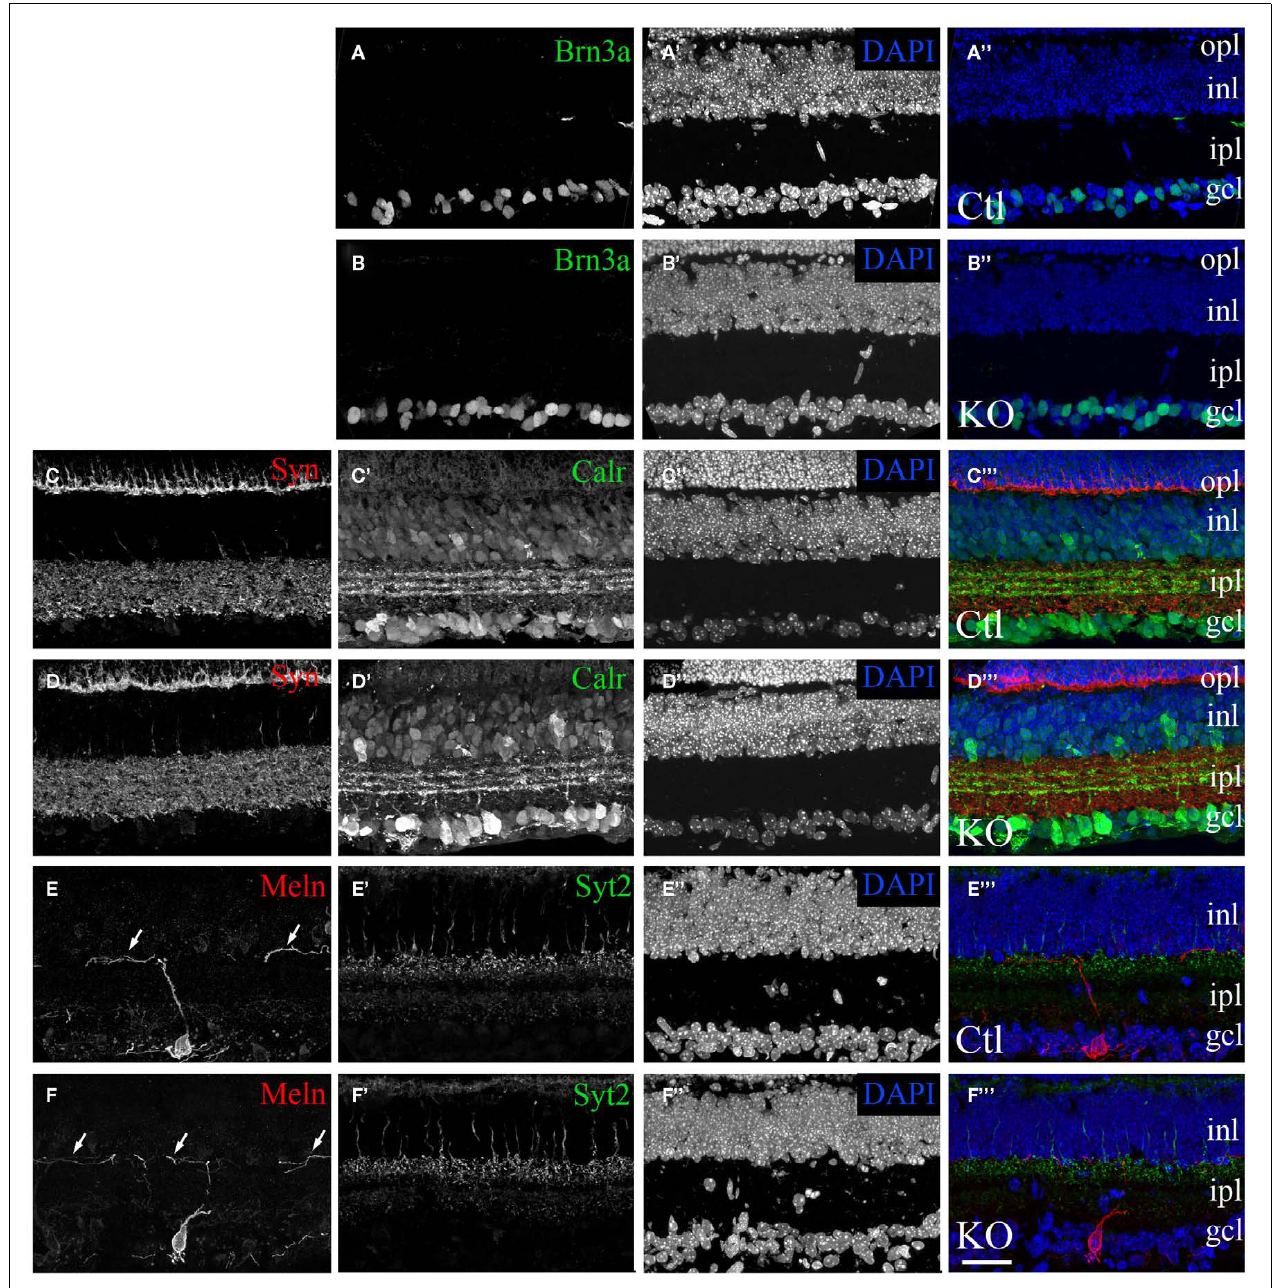
or laminar arrangement of the retina between mutants and controls. Likewise labeling with anti-Syt2, anti-Calr, and anti-melanopsin (Meln) revealed that sublaminar specificity was indistinguishable in controls and mice lacking FGF22 (D,F) and controls (C,E) . Arrows in (E,F) show that dendrites from Meln-expressing RGCs correctly target the inner most region of the IPL in the absence of FGF22. In all sections nuclei were labeled with DAPI. inl, inner nuclear layer; ipl, inner plexiform layer; gcl, ganglion cell layer. Scale bar = 100 μ